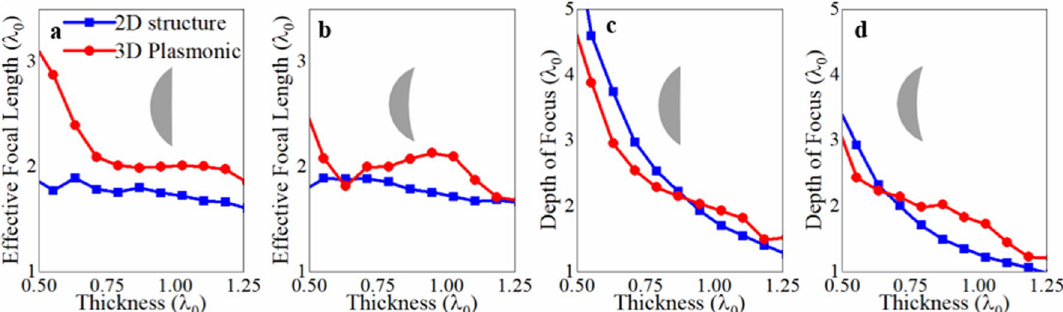
Figure 3. Effective focal length for the 2D lenses illuminated with a plane wave (blue) and 3D plasmonic designs (red) considering ( a ) convex-planar and ( b ) meniscus geometries. Depth of focus for the 2D lenses illuminated with a plane wave (blue) and 3D plasmonic (red) designs having ( c ) convex-planar and ( d ) meniscus output